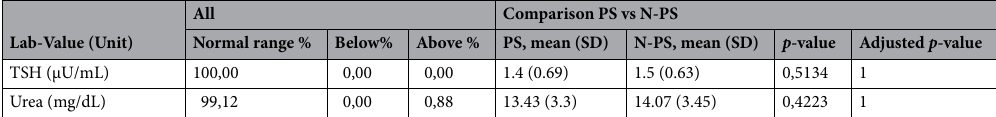
Table 2. Lab values in alphabetical order for all measures with at least 95% availability among all participants. The columns named below and above represent the percentage of patients deviating from the reference range, which encompasses 95% of the healthy population. Comparison PS = Comparison of lab-values in the two cohorts: With vs without persistent symptoms.